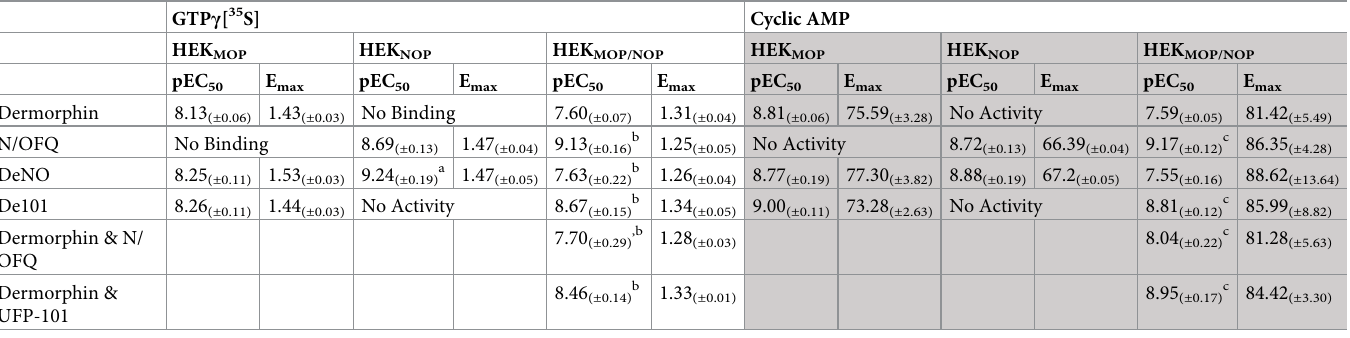
Table 3. Agonist stimulated GTP γ S binding (left) and cyclic AMP inhibition (right-grey) in HEK MOP , HEK NOP and HEK MOP/NOP